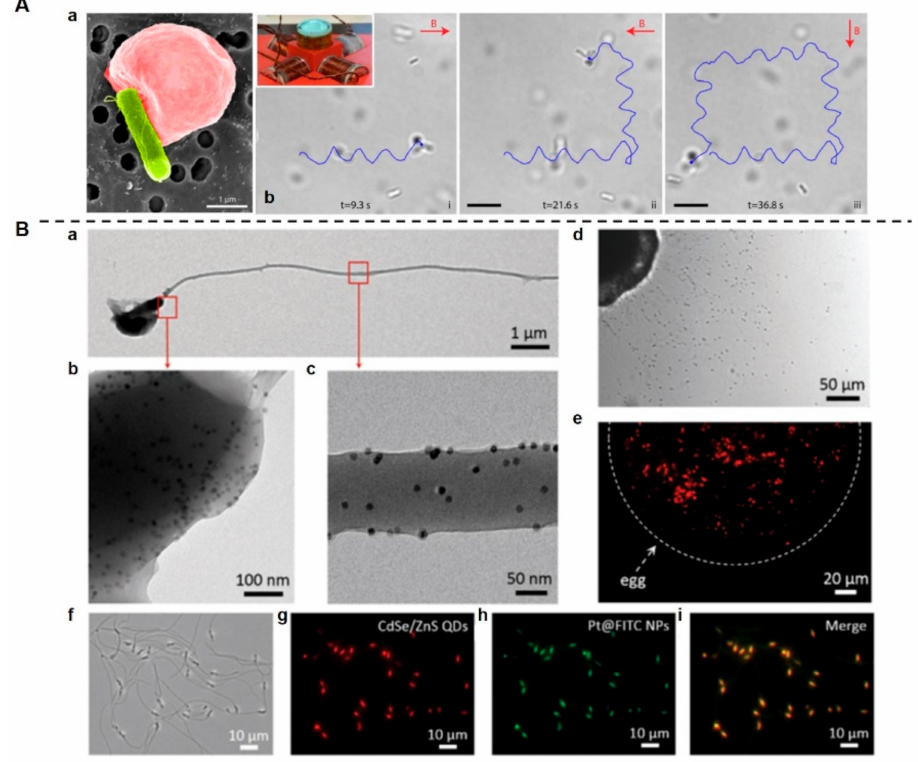
Figure 5. Biohybrid micro-/nanomotors. ( A ). RBC microswimmers for active cargo delivery. ( Aa ) SEM image of an RBC microswimmer with an attached bacterium (pseudo-colored red, RBC; pseudo-colored green, bacterium). RBC microswimmers were constructed through the non-covalent interaction of biotin-functionalized RBCs with streptavidin-coated motile bacteria. ( Ab ) The RBC mi- croswimmer changed swimming direction when the magnetic field direction was changed (i–iii) [176]. Red arrows indicate the direction of the magnetic field. The inset shows the setup used for magnetic steering of the RBC microswimmers. Scale bars = 10 µ m. ( B ). Free-swimming-functionalized sperm micromotors (FSFSMs) for efficient drug-loading and self-propulsion. ( Ba – c ) TEM images of FSFSMs loaded with iron oxide (Fe 2 O 3 ) NPs. ( Bd ) After incubating with the FSFSMs for 10 min, egg cells were surrounded by swarming FSFSMs. The functionalized sperm cells maintained their chemo- tactic ability to sense egg cells. ( Be ) Fluorescence image of an accumulation of FSFSMs on the egg surface. ( Bf ) Microscopic brightfield and ( Bg – i ) fluorescence images of the same sperm motor group functionalized with multiple payloads: CdSe/ZnS QDs ( Bg ), Pt@FITC NPs ( Bh ), and ( Bi ) merged by two fluorescence channels [199]. (Image ( A ) is reproduced with permission from [176] (Copyright © 2018, The American Association for the Advancement of Science). Image ( B ) is reproduced with permission from [199] (Copyright © 2017 John Wiley & Sons,